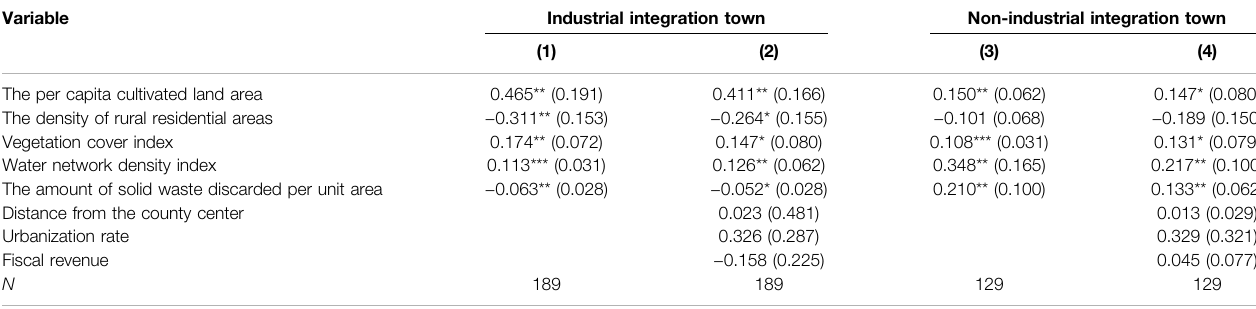
TABLE 6 | Results of heterogeneity analysis.